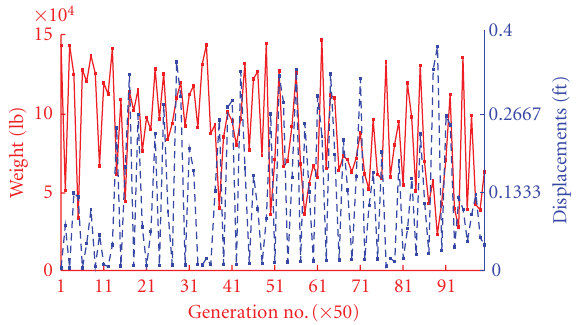
Figure 13: Convergence history obtained by AbYSS (Case 1).